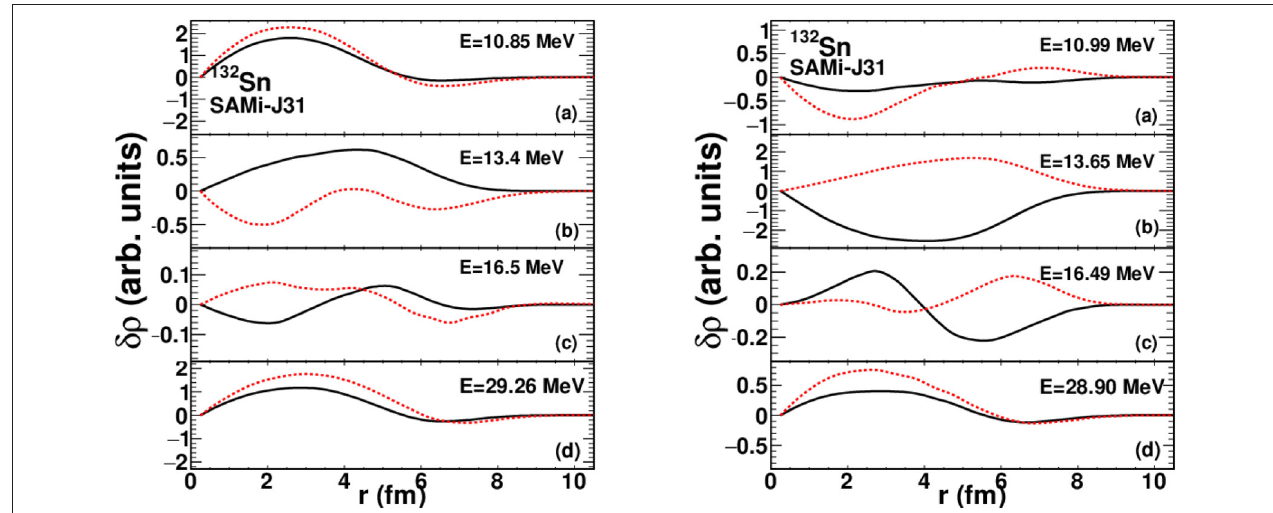
FIGURE 8 | (Color online) Left : the transition densities are displayed as a function of the radial coordinate r for different excitation energies in 132 Sn. An initial IS perturbation and the SAMi-J31 interaction are considered. Dashed lines refer to neutrons, full lines to protons. Right : similar to the Left , but employing an initial IV perturbation. Readapted from Zheng et al.